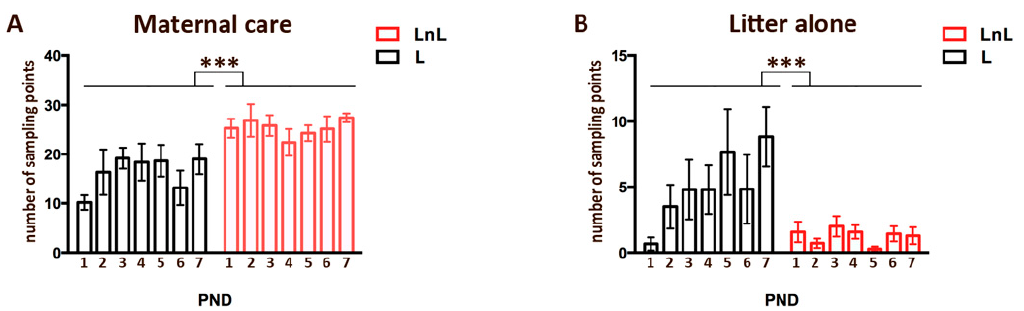
Figure 2. Increased maternal care from LnL mothers during the first postnatal week: ( A ) number of sampling points (mean ± SEM) for active maternal care (nursing posture, grooming, licking, nest building) during daily monitoring (*** p <0.0001; two-way Anova for repeated measures with between factors being L and LnL groups and days being within measures); ( B ) number of sampling points (mean ± SEM) for litter left alone during daily monitoring. (*** p <0.0001; two-way Anova for repeated measures with between factors being L and LnL groups and days being within measures). Daily monitoring consisted of 32 recordings collected during 30-min sessions repeated twice over 7 days. PND = post-natal day.